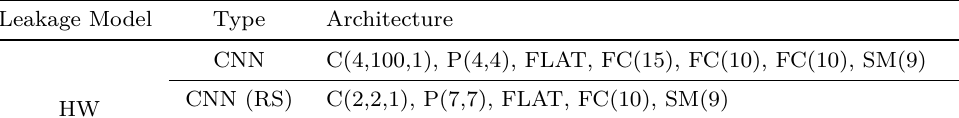
Table 13: The best found architectures for the CHES CTF